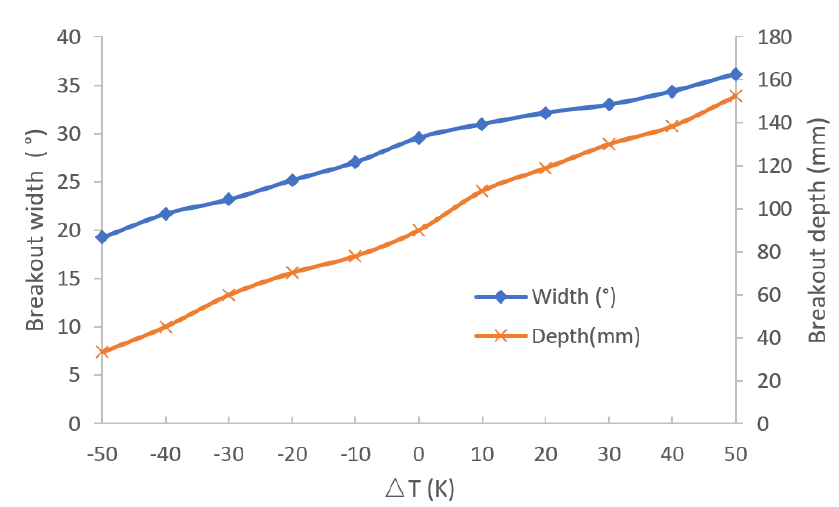
Figure 10. Breakout width and depth for different drilling fluid